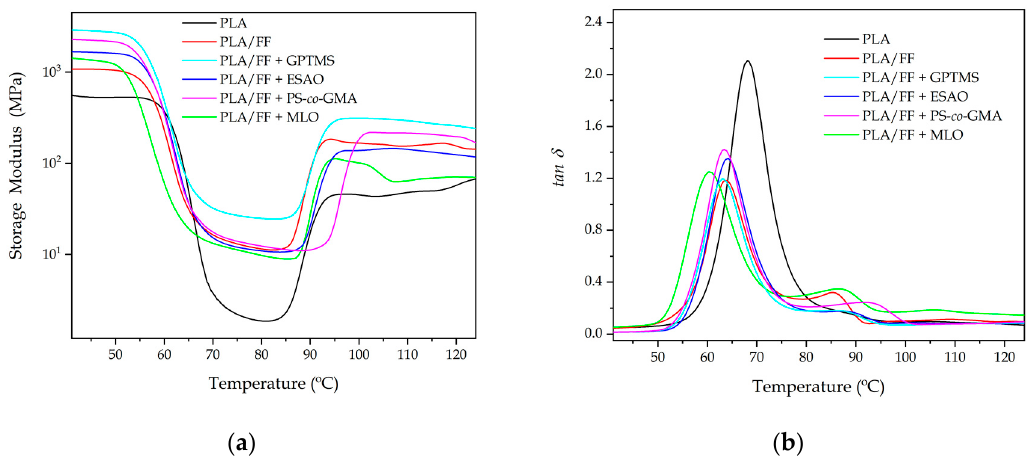
Figure 7. Evolution as a function of temperature of the ( a ) storage modulus and ( b ) dynamic damping factor ( tan δ ) of the polylactide (PLA)/flaxseed fiber (FF) pieces compatibilized with (3-glycidyloxypropyl) trimethoxysilane (GPTMS), epoxy-based styrene-acrylic oligomer (ESAO), poly(styrene- co -glycidyl methacrylate) (PS- co -GMA), and maleinized linseed oil (MLO).